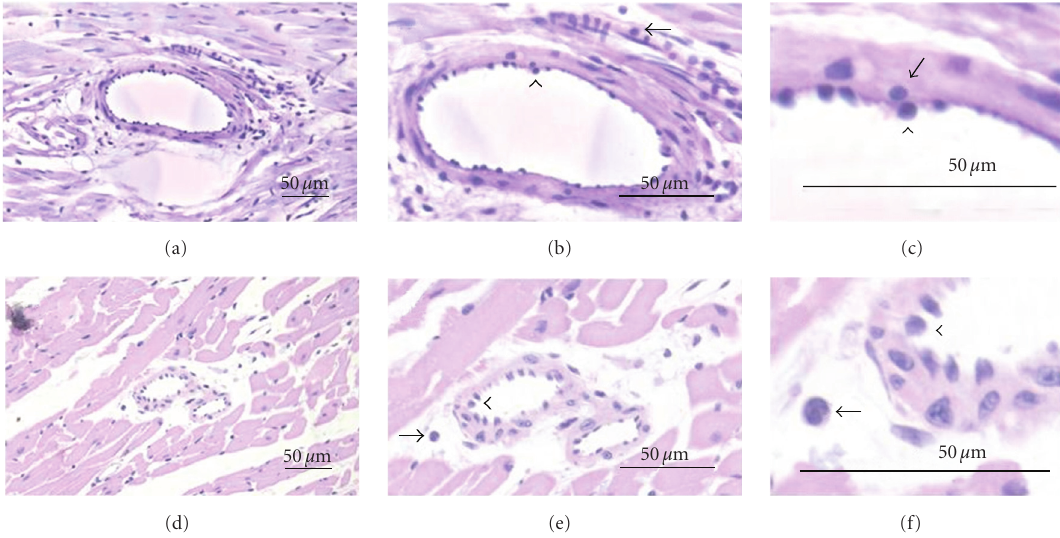
Figure 7: Light microscopy photograph of hematoxylin and eosin-stained rat heart tissue from I/R+PMN and I/R+PMN+BH 4 (10 μ M). (a)– (c), I/R+PMN heart illustrated enhanced PMN coronary vascular adherence and tissue infiltration ((a): 20x; (b): 40x; (c): 100x). (d)–(f), I/R+PMN+BH 4 (10 μ M) heart exhibited a reduction in PMN coronary vascular adherence and tissue infiltration compared with I/R+PMN ((d): 20x; (e): 40x; (f): 100x). Arrows indicate infiltrated PMN and arrowheads indicate PMN adherence to coronary vasculature. Scale bar, 50 μ